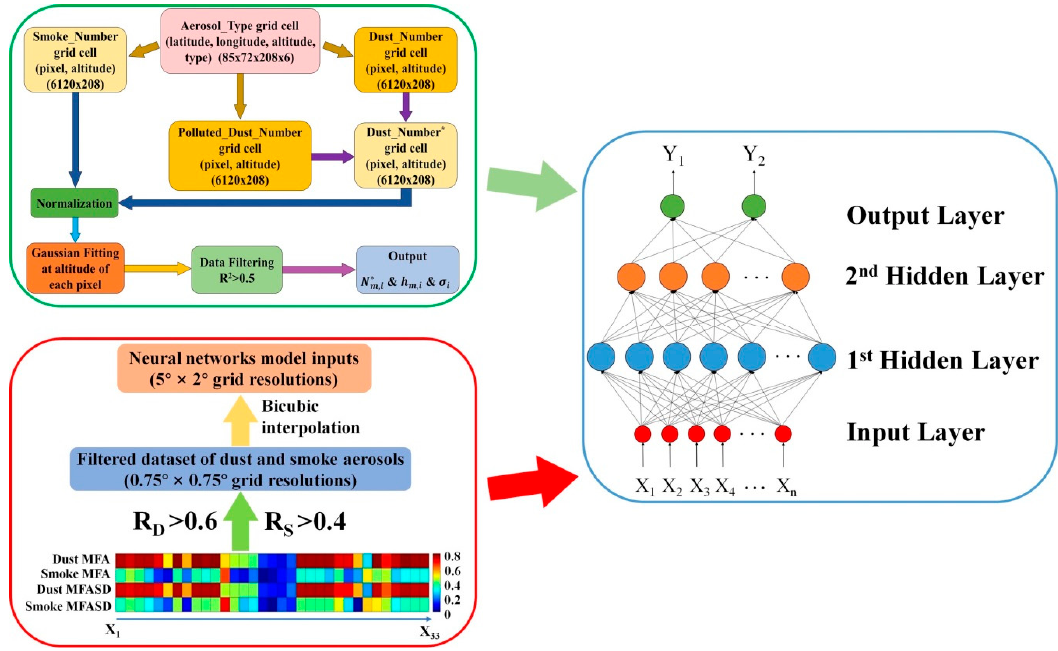
Figure 1. Flow chart of the retrieval process of absorbing aerosol vertical distribution parameters based on Gauss curve fitting and NN models. Green box presents the Gauss curve fitting process. Red box presents the data preprocess. Blue box presents the NN model.